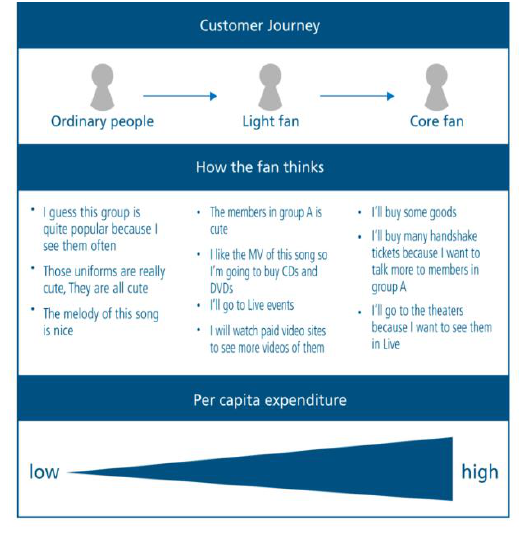
Fig. 3 Fan-Oshimen